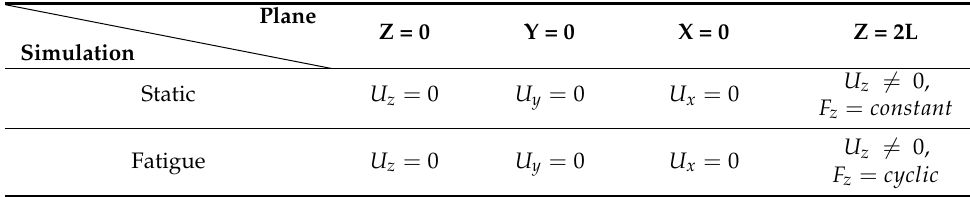
Table 2. Boundary